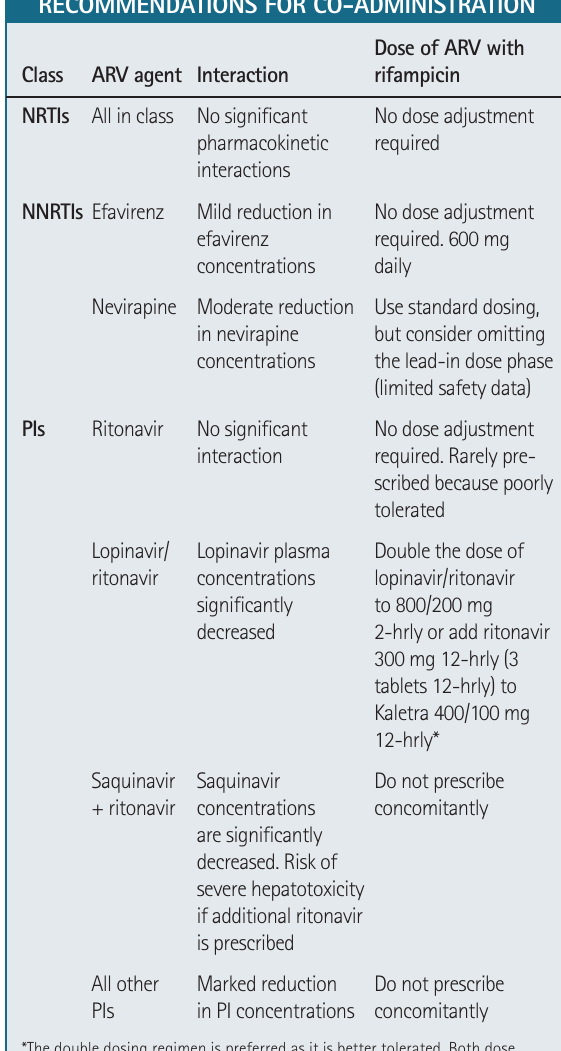
tAble Vi. ARV iNteRActioNs With RifAMPiciN ANd